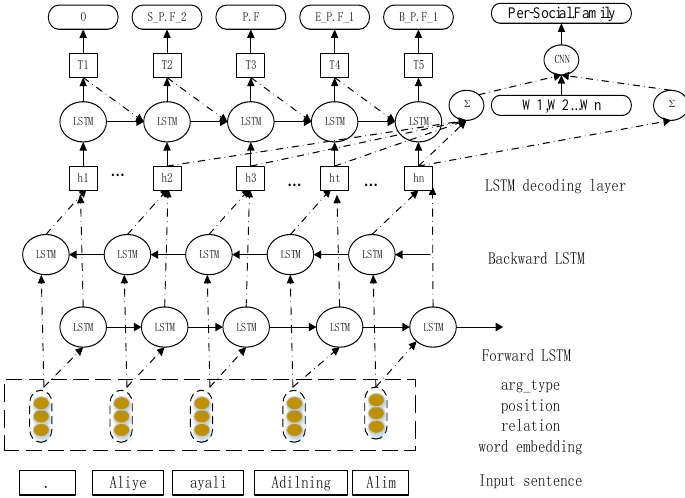
Figure 1. The framework of the hybrid neural network for jointly extracting entities and relations.